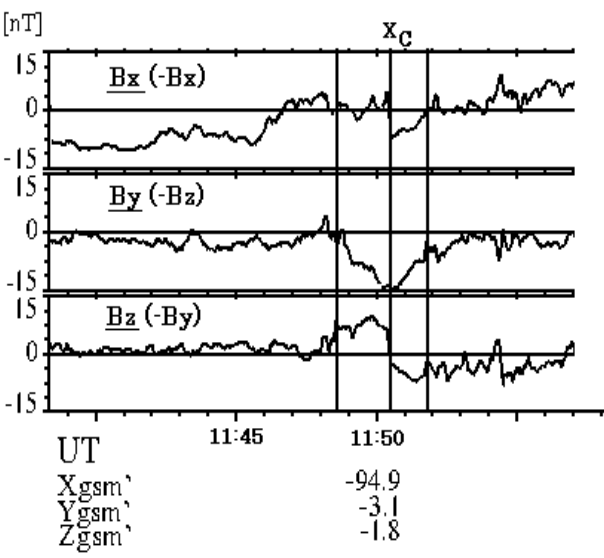
Fig. 1. Geotail satellite observations of magnetic fields of a plas- moid in the aberrated geocentric solar magnetosphere (GSM) coor- dinates, where the corresponding magnetic field components for the present numerical corrdinate system are shown in parentheses, and X C indicates the plasmoid center (after Ieda et al., 1998).